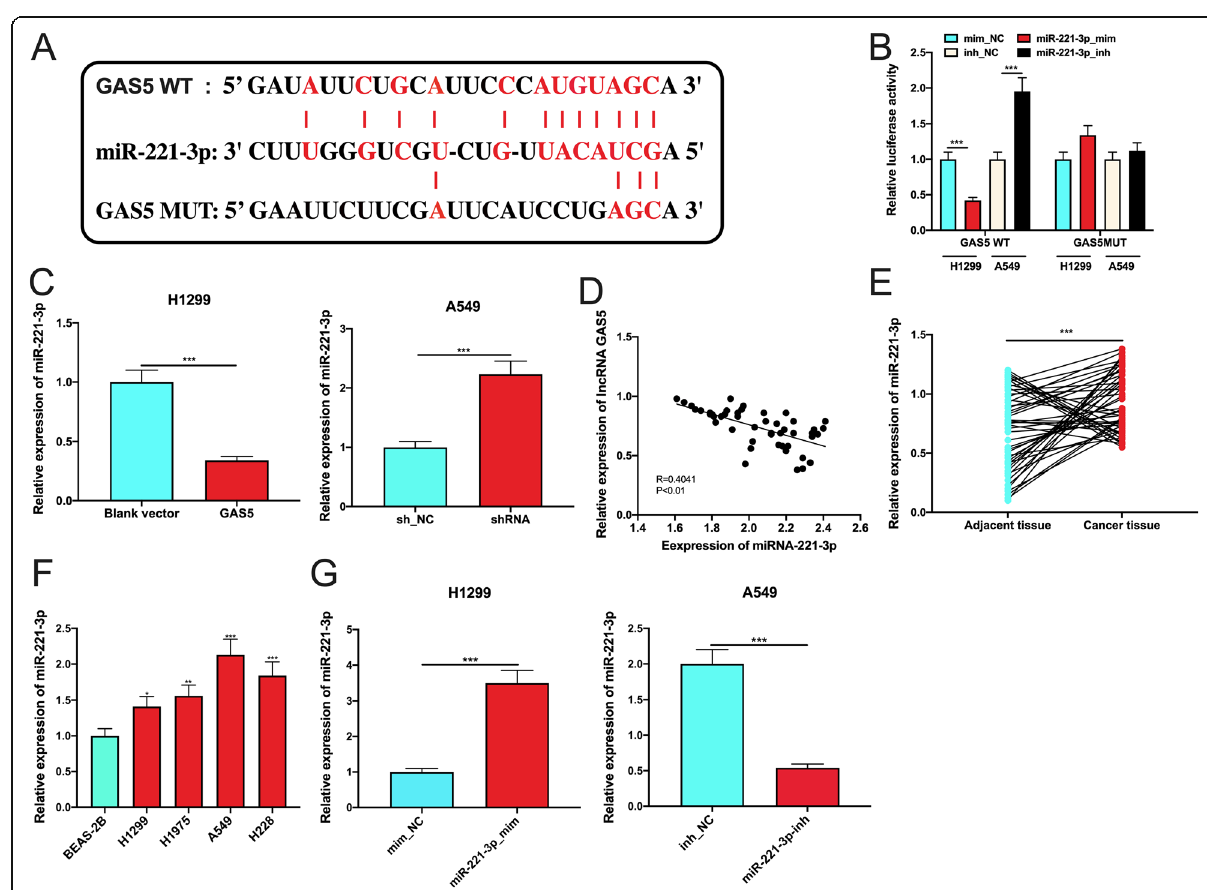
Fig. 3 miR-221-3p was validated to be one of the downstream targets of GAS5. a The binding sequence between GAS5 and miR-221-3p was predicted by the StarBase database. b Verification of the binding site between miR-221-3p and GAS5 was conducted by dual-luciferase reporter gene experiment. c The effects of overexpression and knockdown of GAS5 on miR-221-3p expression in NSCLC cells were detected by qPCR. d The correlation between GAS5 and miR-221-3p expressions in NSCLC tissues. e MiR-221-3p expression in NSCLC tissues and paracancerous tissues was detected by qPCR. f MiR-221-3p expression in human normal lung epithelial cell line and each NSCLC cell line was detected by qPCR. g Transfection efficiency of miR-221-3p mimics and miR-221-3p inhibitors was verified using PCR. *** represents P <